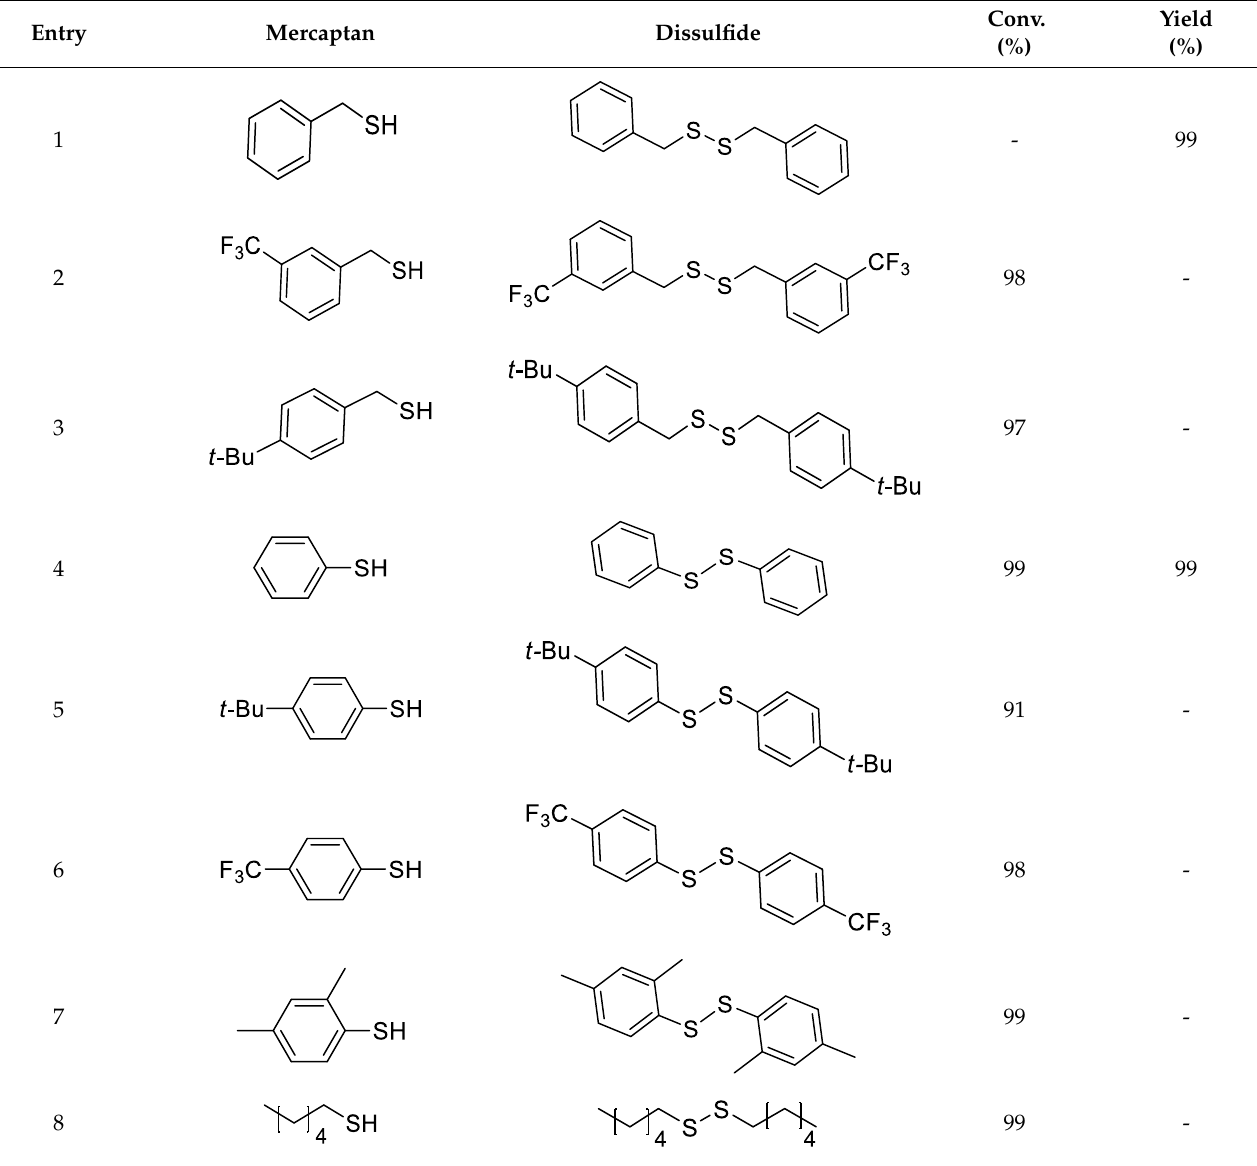
Table 3. Examples and scope of the Fe(II)Pc catalyzed cross-dehydrogenative coupling (CDC) reactions using DIPA as base [64] .